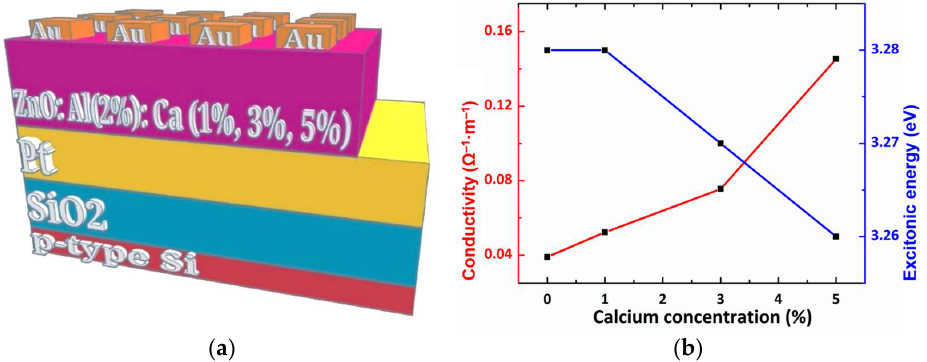
Figure 5. ( a ) The set-up for the I–V measurements; ( b ) electrical conductivity and excitonic energy values as a function of calcium concentration of Ca doped ZnO: Althin